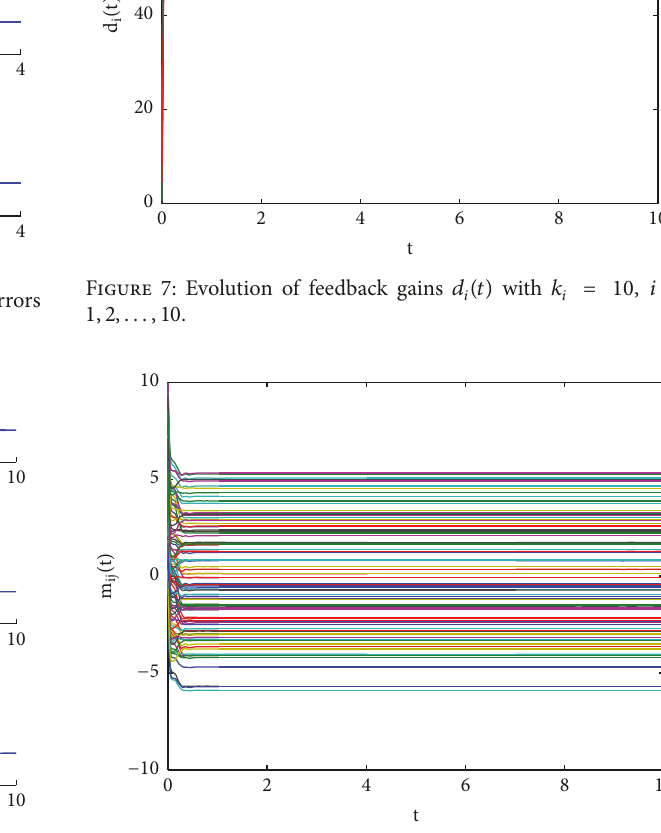
Figure 6: Mixed synchronization errors 𝑒 𝑖 (𝑖 = 1,2,...,10) with 𝐴 ̸= 𝐵 .